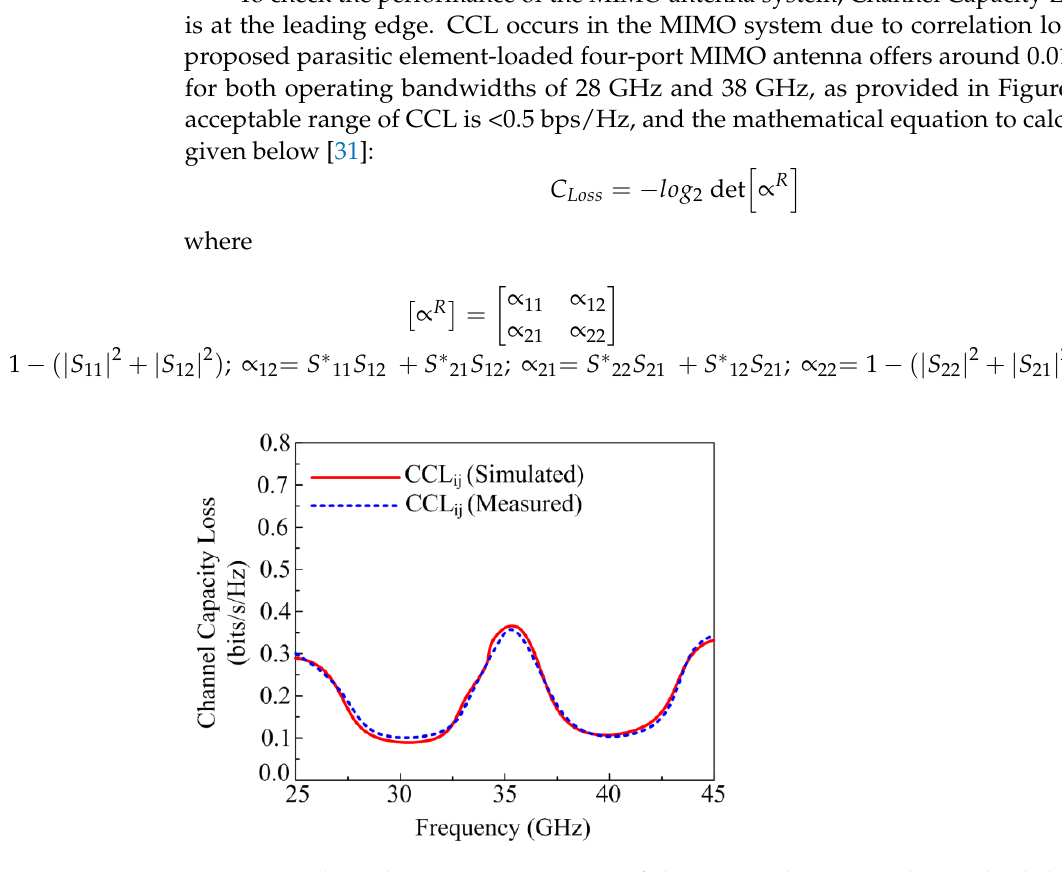
Figure 15. Channel Capacity Loss (CCL) of the proposed parasitic element-loaded dual-band MIMO antenna.